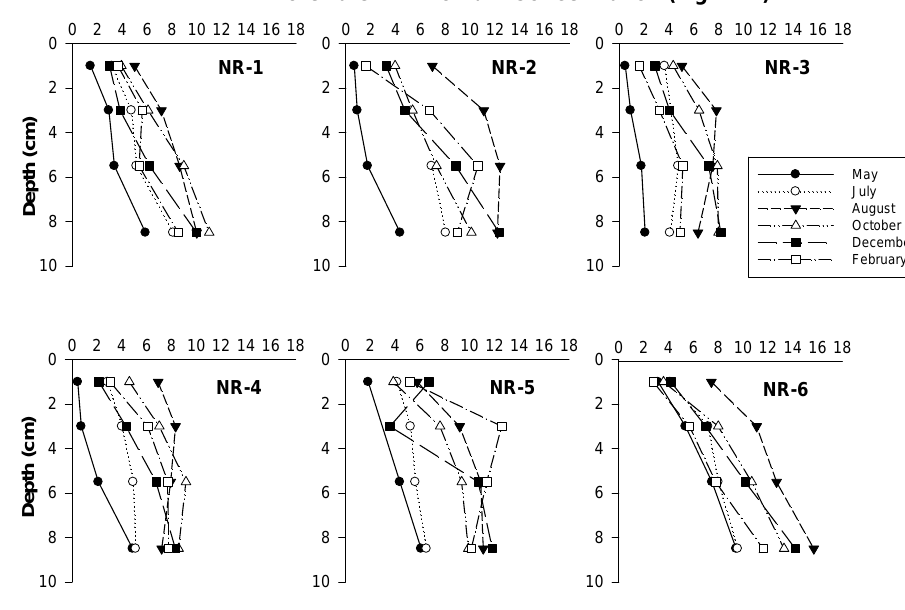
Fig. 5. Porewater concentrations for NH +